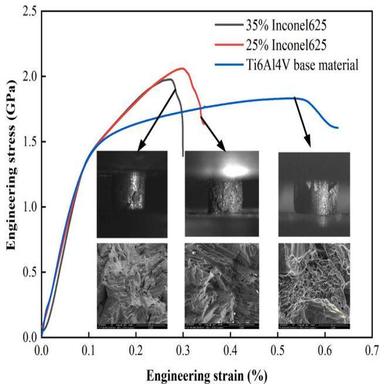
Displacement load curves.